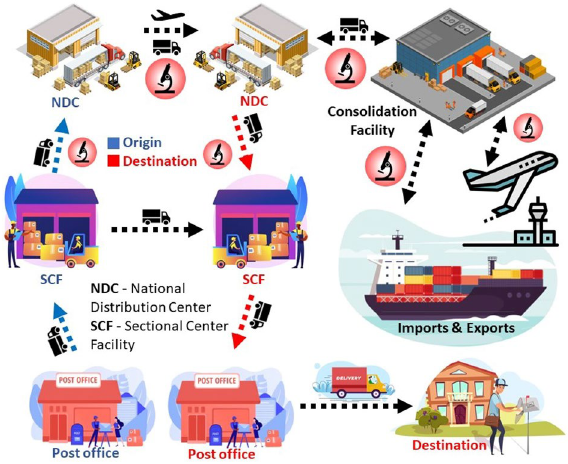
Figure 2. The mail life cycle from origin to destination, which can proceed through different modes 7,8